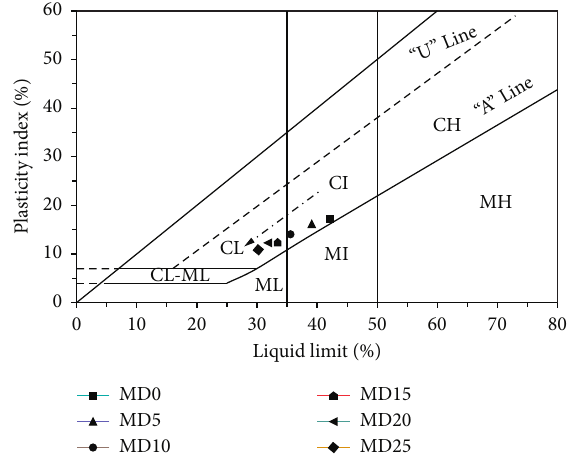
Figure 6: Positions of UECS and TECS on the plasticity chart.